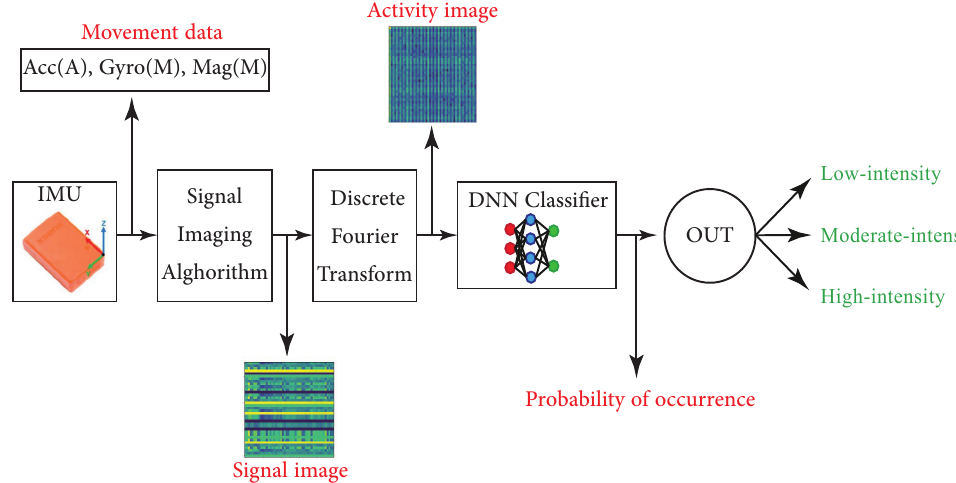
Figure 1. Overview of activity recognition model proposed in this study.